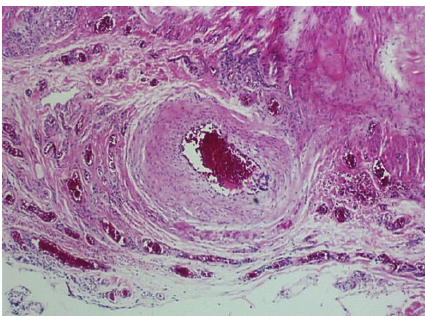
Figure 4: Ligature of the accessory vascular branches.